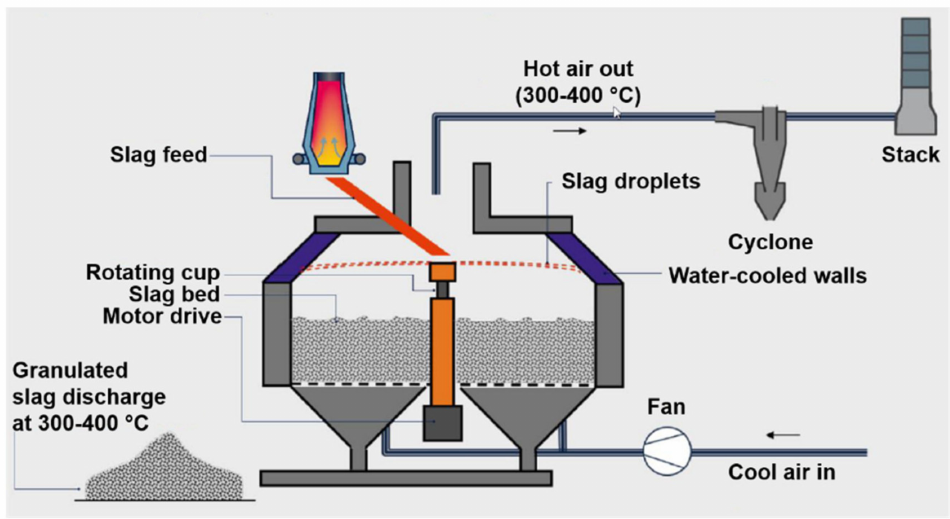
Figure 9. Schematic of the DSG process flow